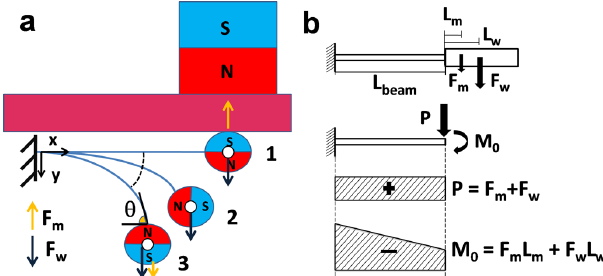
Figure 3. (a) Schematic representation of compliant MLS opera- tion. In the equilibrium point (2) the magnetic force is negligible. (b) Force analysis and distribution considering the flexible joint like an isotropic homogeneous linear elastic beam and the head as a non- deformable body. L w and L m are the distances from the beam tip to the centre of gravity and the centre of donut-shaped magnets respec- tively. L beam is the elastic beam